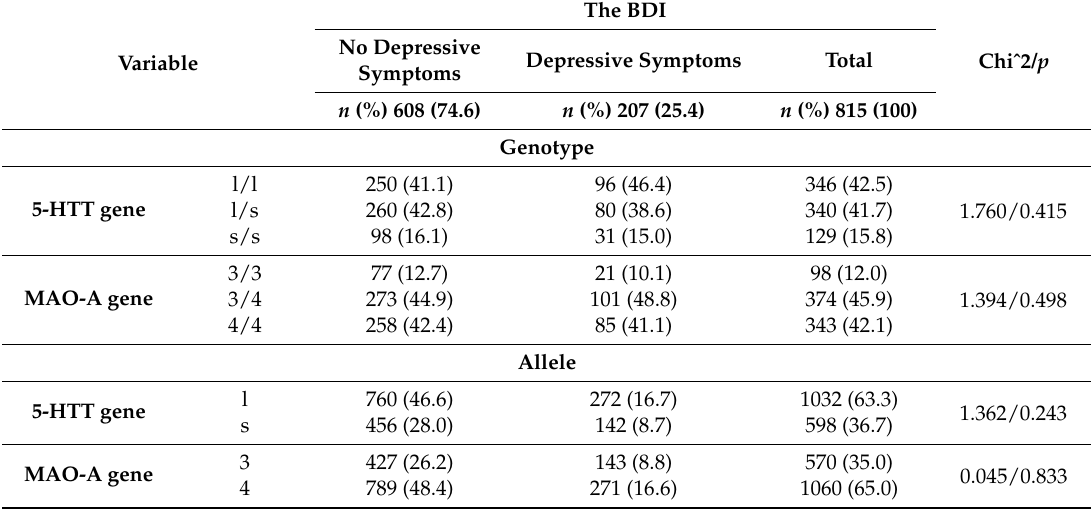
Table 2. The genotype distribution and the frequency of the alleles of the 44-bp variable number of tandem repeats (VNTR) polymorphism in the 5-HTT ( SLC6A4 ) promoter region, and the 30-bp VNTR polymorphism in the MAO-A promoter region in the peri, pre- and postmenopausal women.